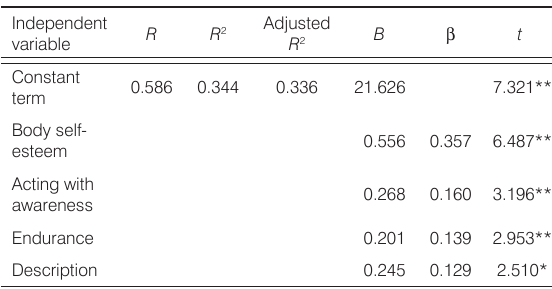
Table 3. Multiple linear regression analysis of physical self and mindfulness to academic possible selves of freshman nursing